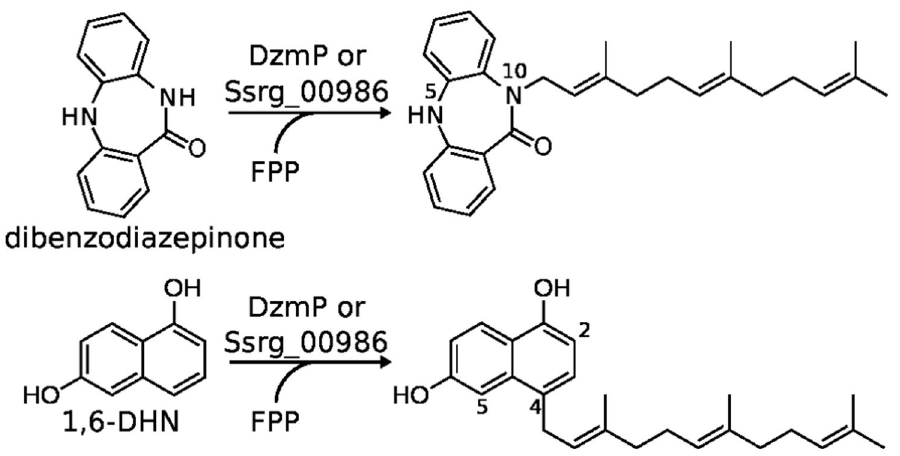
Figure 2. Reactions catalyzed by DzmP and Ssrg_00986. FPP, farnesyl diphosphate; 1,6-DHN, 1,6-dihydroxynaphthalene. doi: